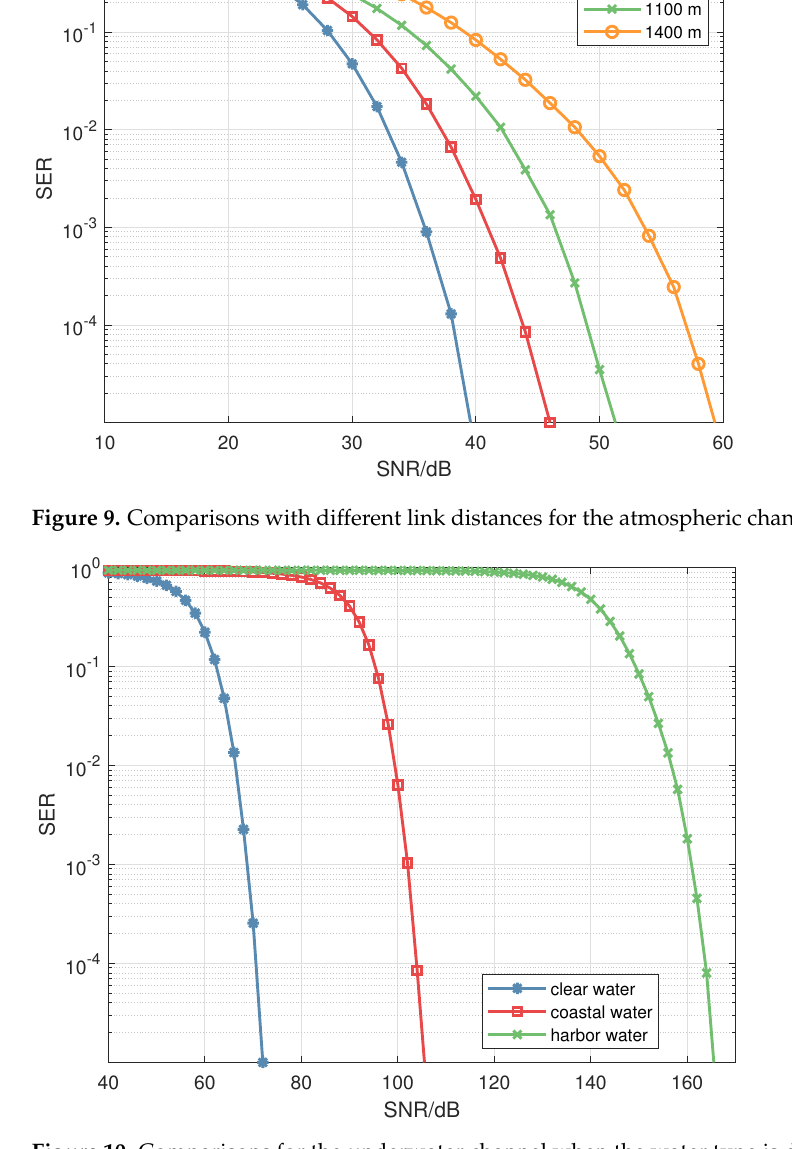
Figure 10. Comparisons for the underwater channel when the water type is